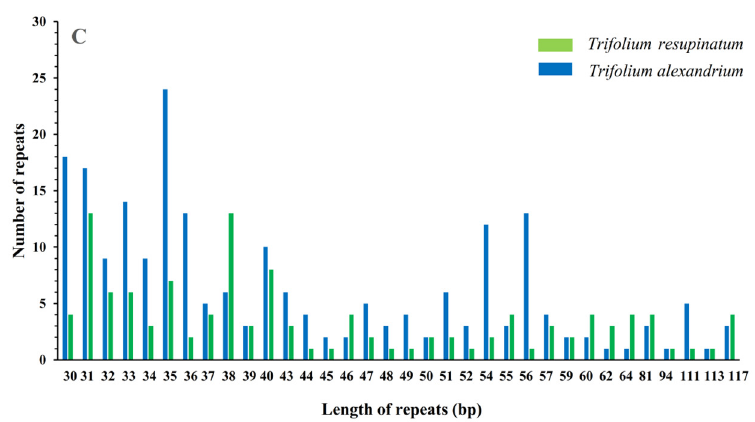
Figure 2. Repeating events of shared genes of T. alexandrinum and T. resupinatum. ( A ) Shared length of repeats and repeated sequences of T. alexandrinum and T. resupinatum ; ( B ) Repeat type predicted in T. alexandrinum and T. resupinatum and ( C ) Listing of shared repetitive sequences with more than 30 bp.